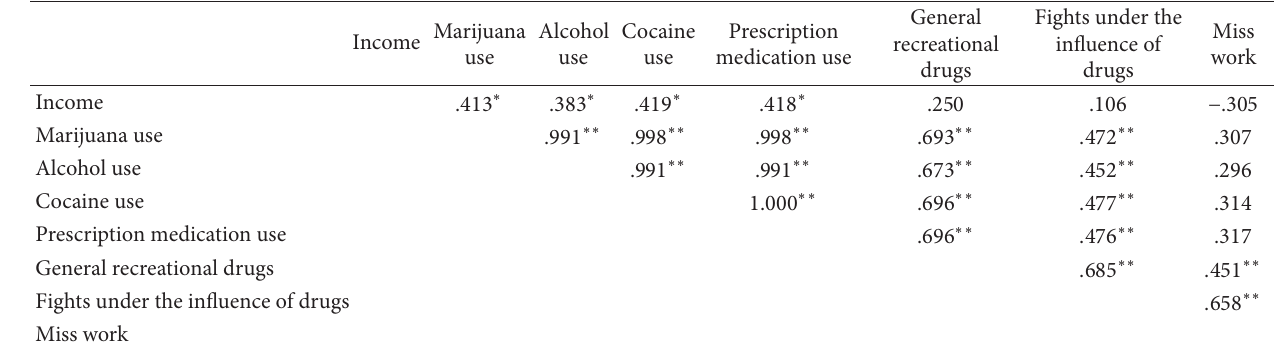
Table 1: Correlations between income and substance use.